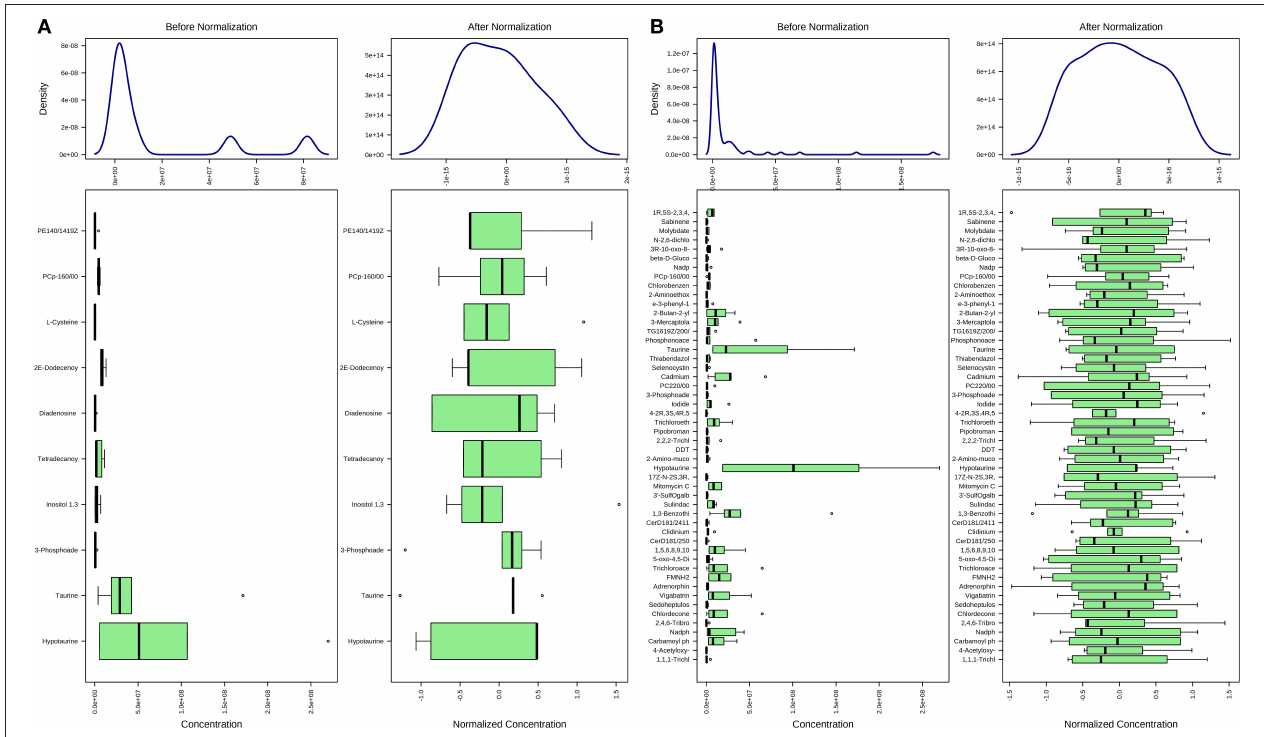
FIGURE 2 | Normalization of common metabolites of spermatozoa (A) and seminal plasma (B) of both groups, prior to statistical analysis based on quantile normalization, log transformation and pareto scaling.